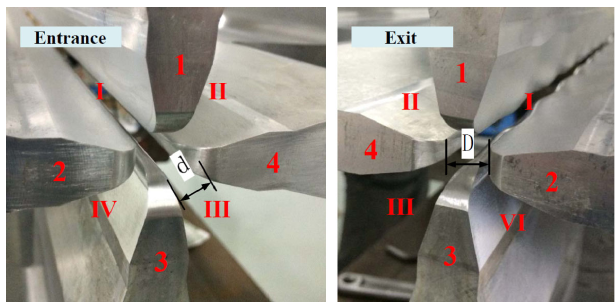
FIG. 17. The measurement of the cold model.